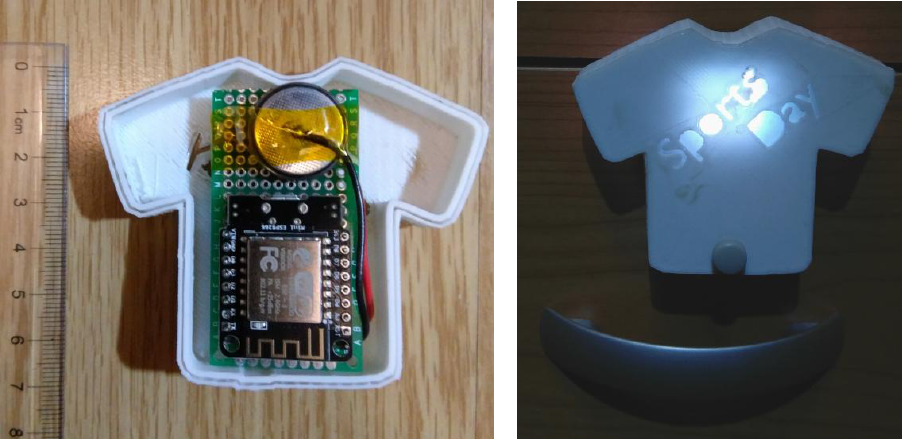
Figure 3. Prototype developed to remind people of sportswear to promote physical activity. ( Left ) Dedicated device and case, ruler for reference; ( Right ) Device powered-on. Table 3. Five Ws description of sportswear notification.